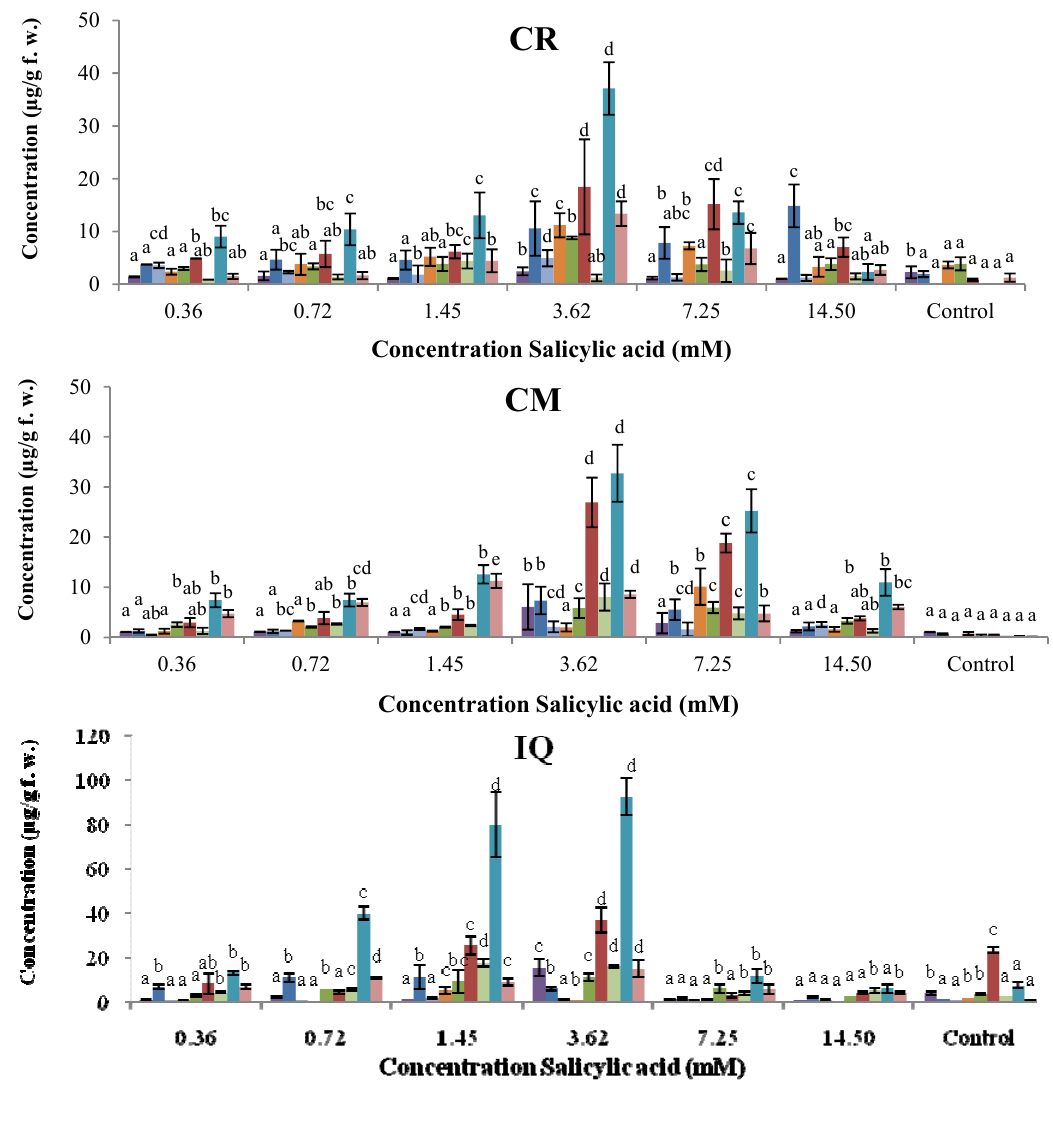
Figure 3. Accumulation of isoflavonoid phytoalexins on cotyledons of Phaseolus vulgaris by SA at different